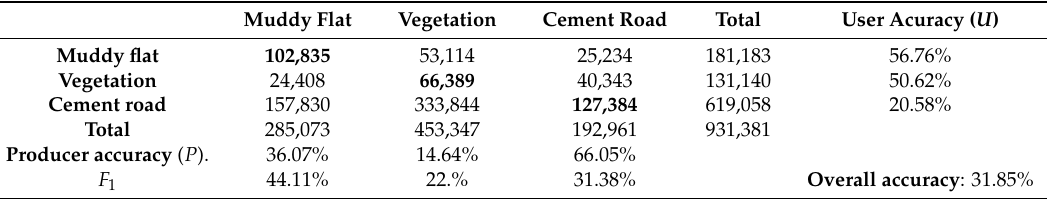
Table 5. Confusion matrix of classification by original intensity data.